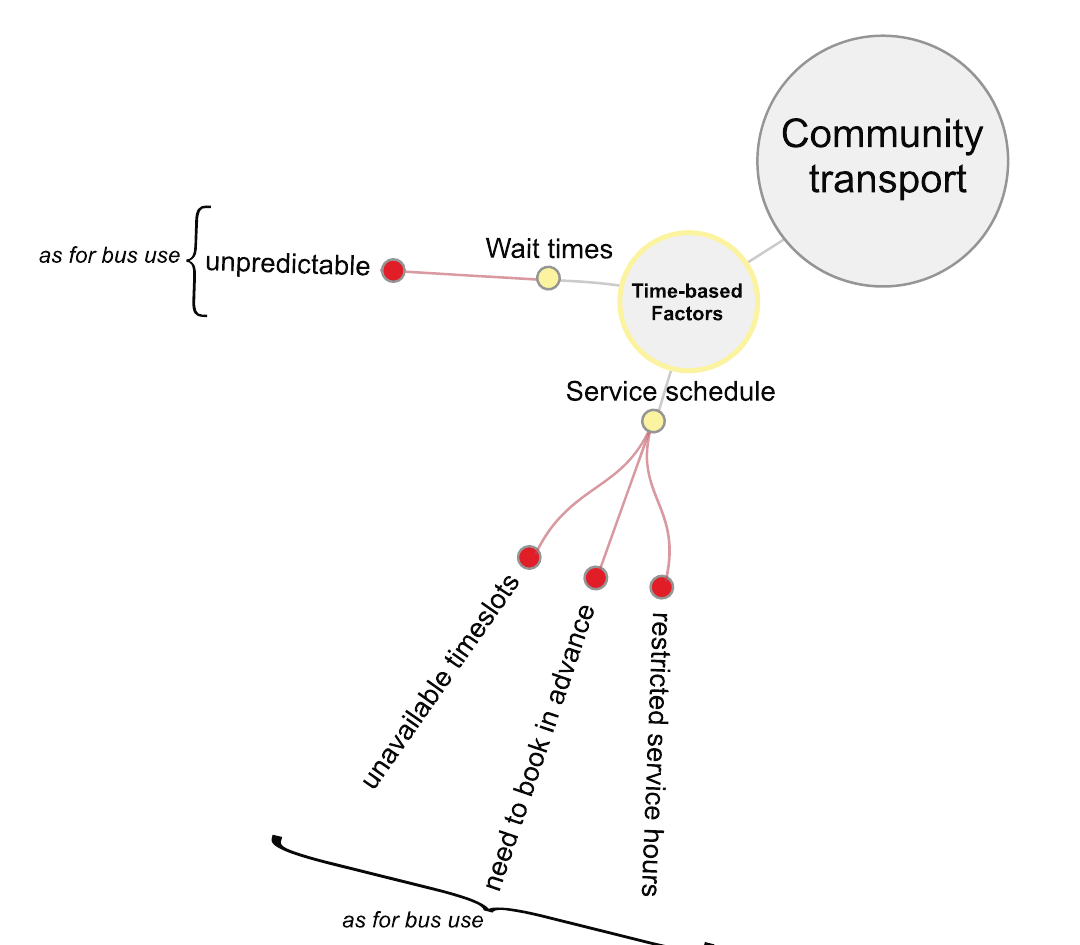
Figure A3. Radial dendrogram depicting the influences on older people’s community transport use, as derived from 1 article.